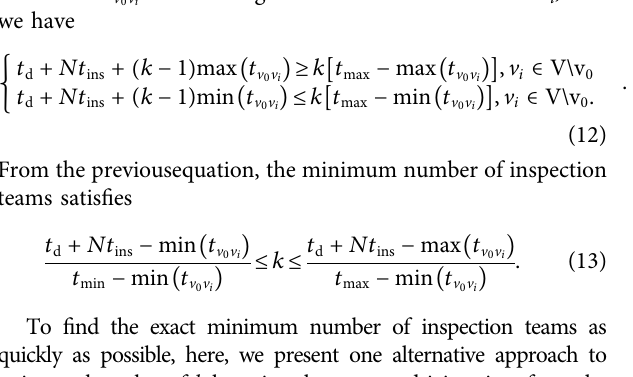
Frontiers in Physics |